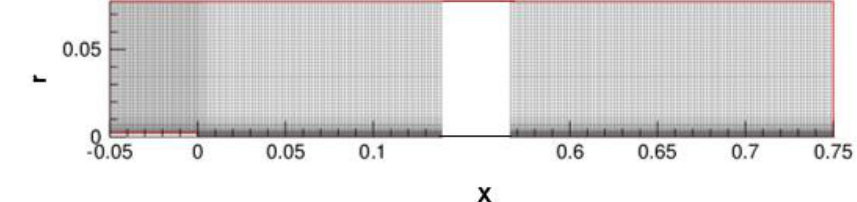
Figure 2. Meshing of the computational domain